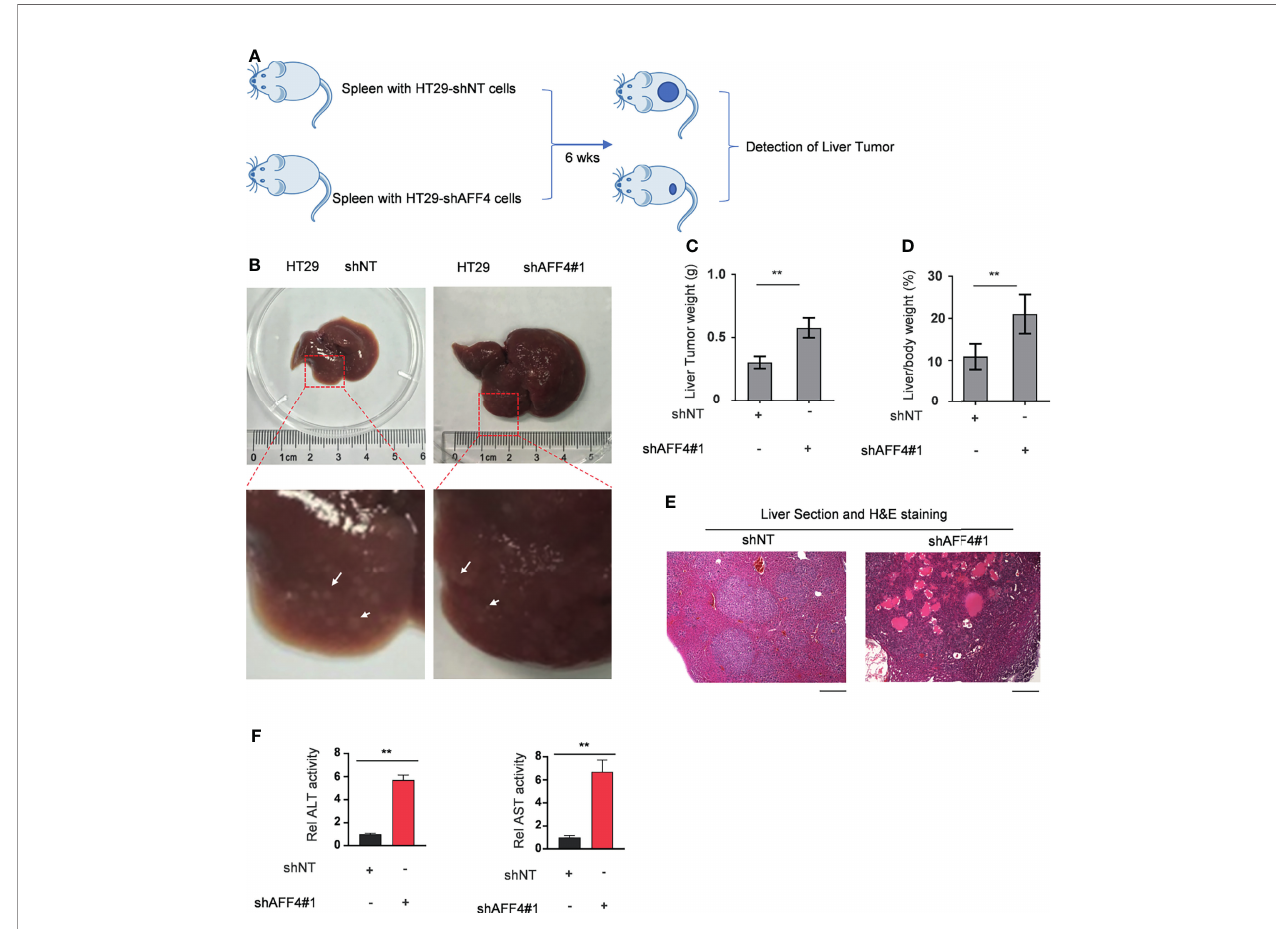
FIGURE 4 | AFF4 depletion conferred CRC cells more aggressive capacity of metastasis to liver. Data are presented as the mean ± SD or SEM and are analyzed by unpaired t -tests. ** p < 0.01. (A) The work follows a liver metastasis model. A total of 50,000 HCT116 cells expressing shNT or shAFF4 were injected into the spleen of nude mice ( N = 4), then after 6 weeks, the metastatic lesions in the liver of nude mice were observed and tumor samples were separately collected. (B) After the mice were sacri fi ced, the representative images of liver metastases nodules were photographed and enlarged, then marked with a white arrow. (C – F) The analysis of liver metastasis with AFF4 genetically manipulated HCT116 cells. The weight of liver with metastases nodules was fi rst measured and calculated (C) . The weight ratio of liver to the whole body of mice after metastasis was then calculated (D) . Hematoxylin-eosin (H&E) staining was performed to show the tumor cells in the liver metastasis nodule specimens (E) . The enzymatic activities of glutamic-pyruvic transaminase (ALT) and glutamic oxalacetic transaminase (AST) were measured using a kit to indicate the liver function. The value of enzymatic activities in the shAFF4 group was normalized to the control group (F) . Scale bar, 1